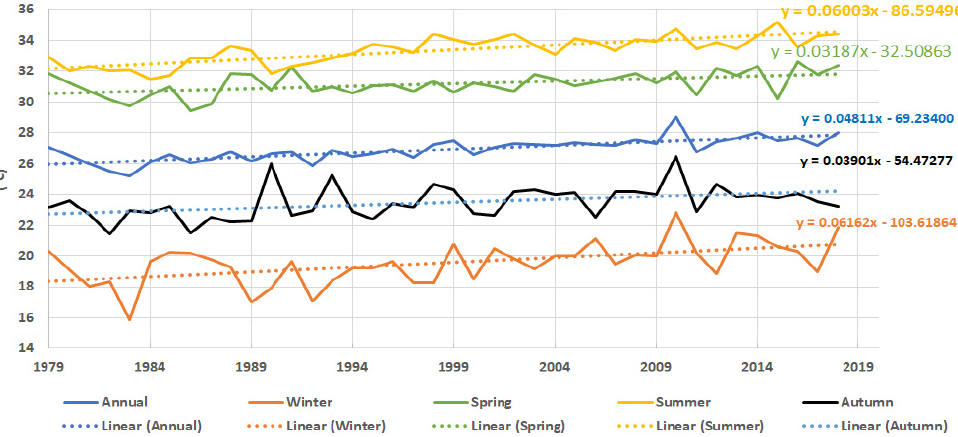
Figure 19. Annual/seasonal surface air temperature time series for Aswan High Dam Reservoir.